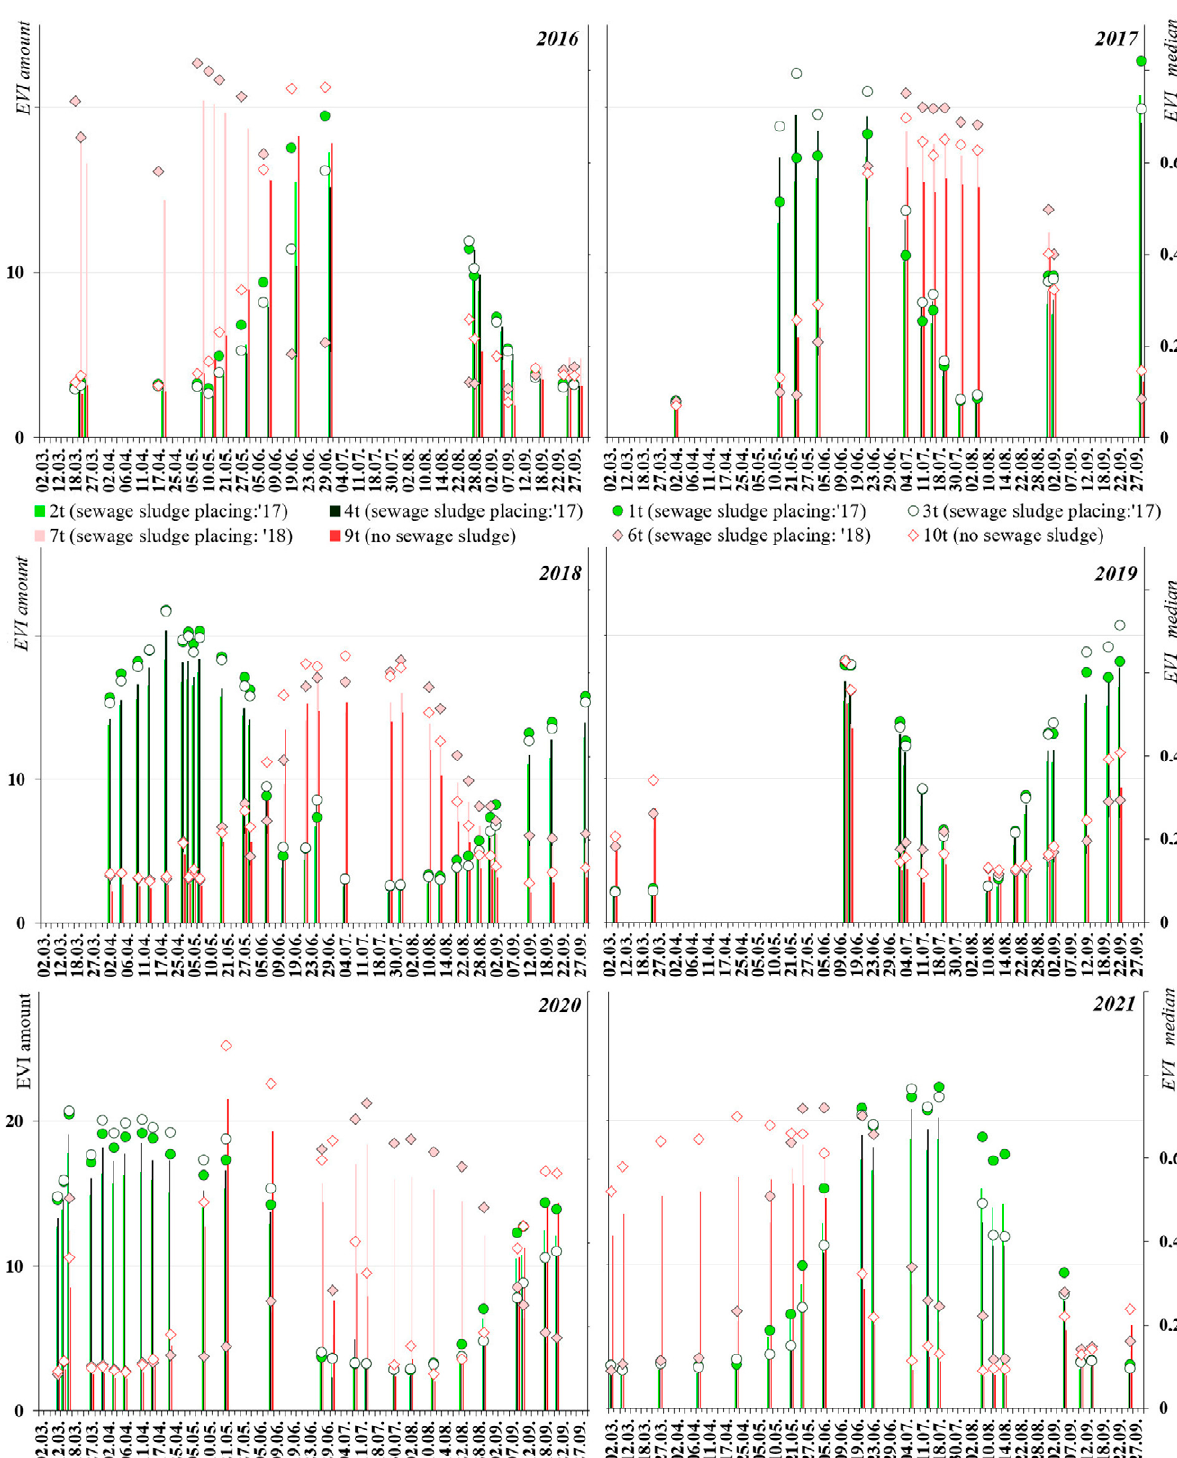
Figure 4. EVI values of quadrates of Újkígyós study site between 2016 and 2021 (points: EVI median, columns: EVI total) (1t-4t: sewage sludge placing in 2017; 6t-7t: sewage sludge placing in 2018; 9t-10t: no sewage